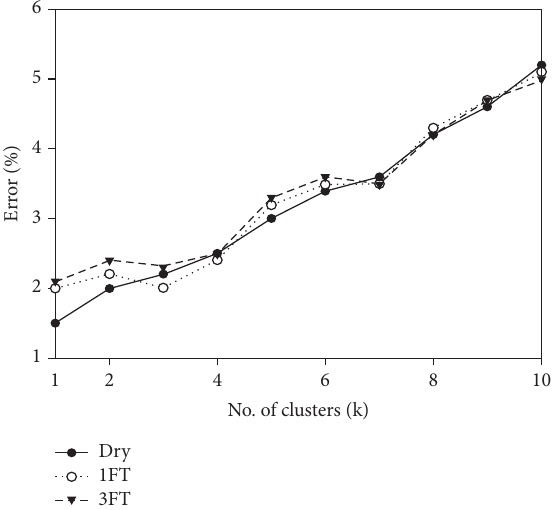
Figure 12: Accuracy of PKIP using openMP.